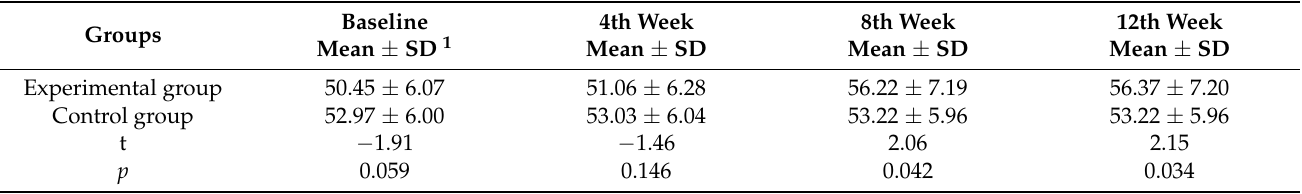
Table 3. Comparison of sense of coherence score between the experimental and control groups at various time